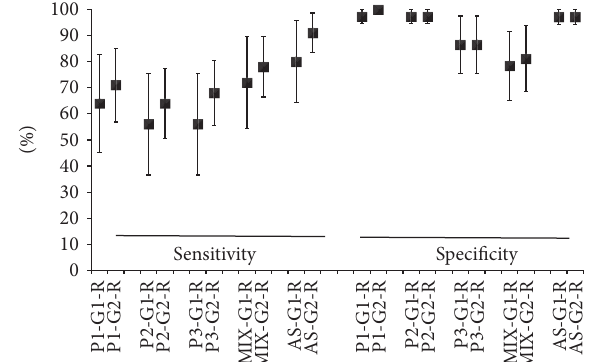
Figure 4: Performance of ELISA test with synthetic peptides and sera of patients with cutaneous leishmaniosis. P1: peptide 1; P2: pep- tide 2; P3: peptide 3, MIX: P1 + P2 + P3; G1: Group 1 (patients with clinical cutaneous leishmaniosis and parasites isolated); G2: Group 2 (patients with clinical cutaneous leishmaniosis and serological diagnosis positive); SA: soluble